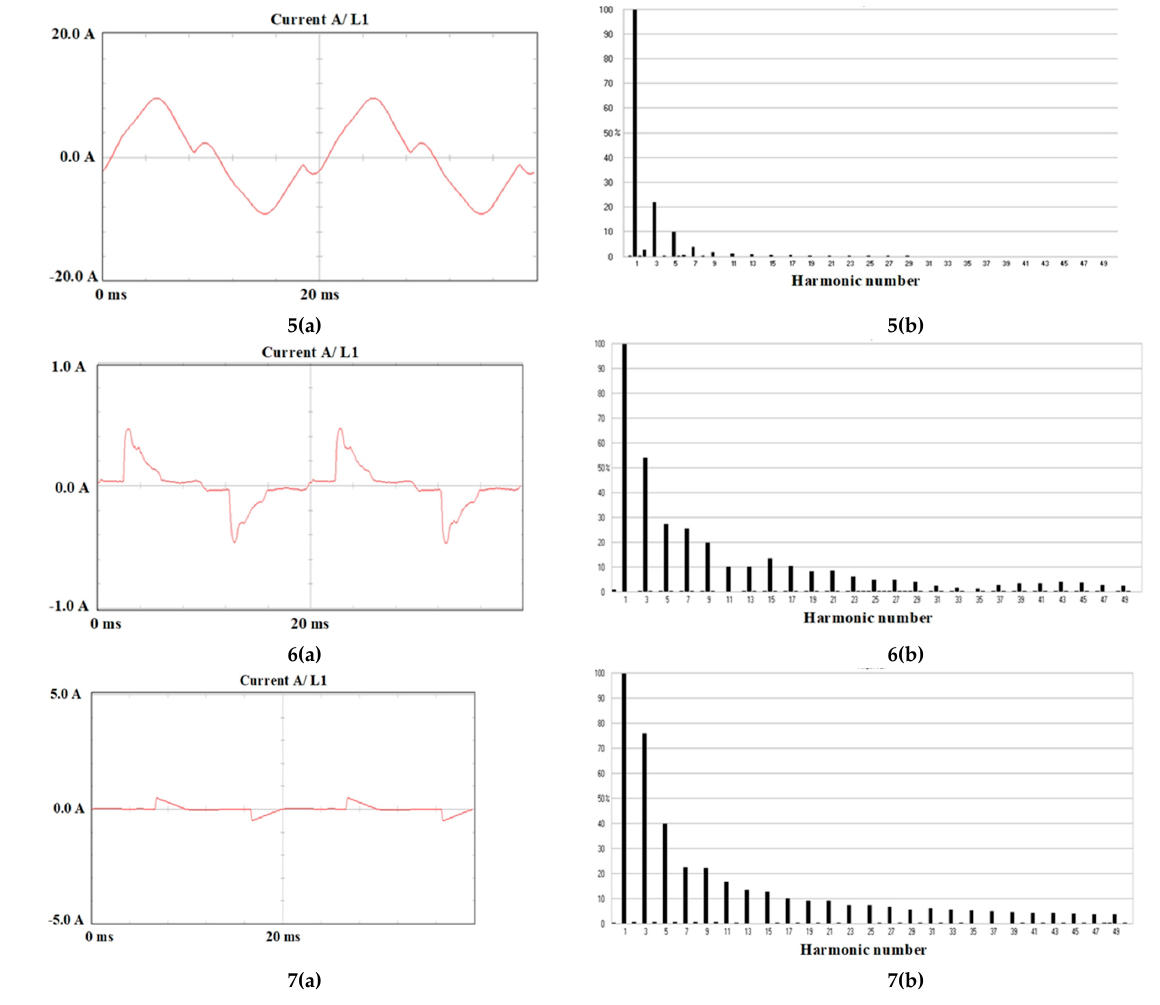
Figure 6. Measurements obtained for individual devices: ( a ) current waveform; ( b ) harmonic spectrum; 1—AC Power Adapter, 2—Adaptive Fast Smartphone Charger, 3—LCD monitor–20”, 4—Vacuum cleaner, 5—Microwave oven, 6—Compact fluorescent lamp, 7—Dimmer and incandescent lamp. Table 3. Current total harmonic distortion factor ( THD I ) measurements obtained for individual